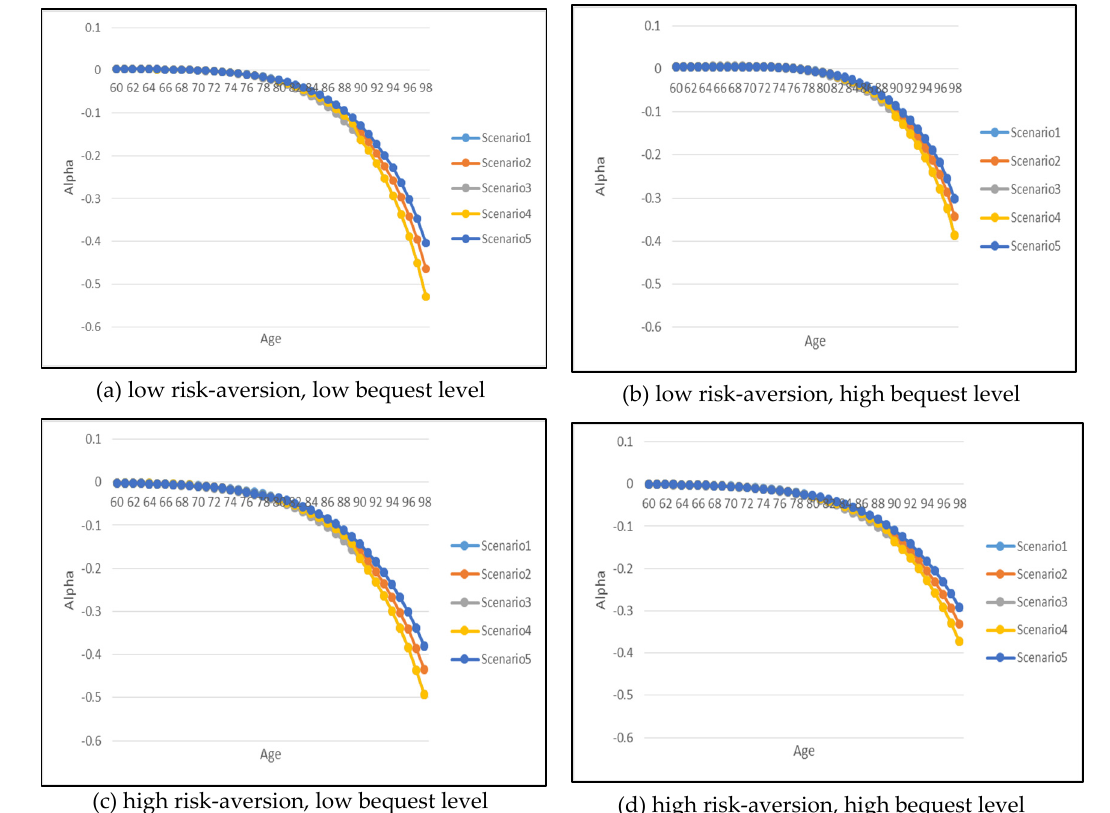
Figure 7. Optimal Annuity/Insurance Purchase for Females (Health-Independent Utility).